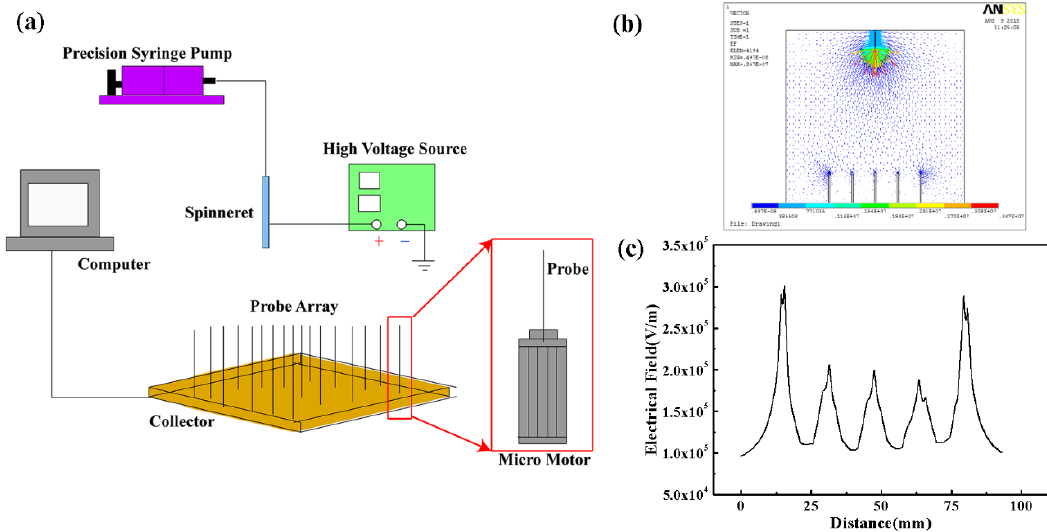
Figure 1. Schematic diagram of the proposed electrospinning setup and simulation of induced electrical field. ( a ) Experimental schematic diagram; ( b ) Electrical field distribution; ( c ) variation curve of electrical field along the line of probe tips (red line in Figure 1b). Poly (Ethylene Oxide) (PEO, M w = 300,000 g/mol, Dadi Fine Chemical Co, Ltd., Changchun,